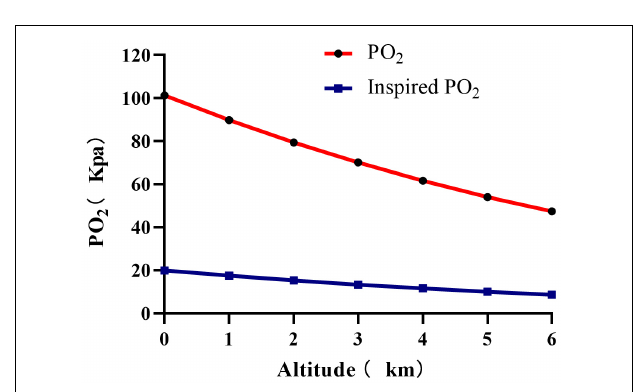
FIGURE 5 | Plots of oxygen partial pressure(PO2) and inspired oxygen pressure(PiO2) at different altitudes.